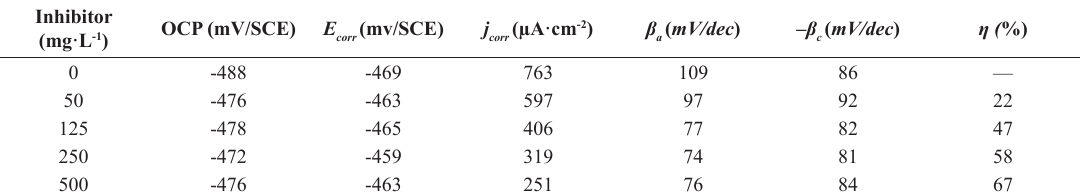
Table 1: Kinetic parameters obtained from Tafel plots for C‑steel in 1.0 mol L -1 H extract at the following concentrations: 50, 125, 250 and 500 mg·L -1 at 25 °C.